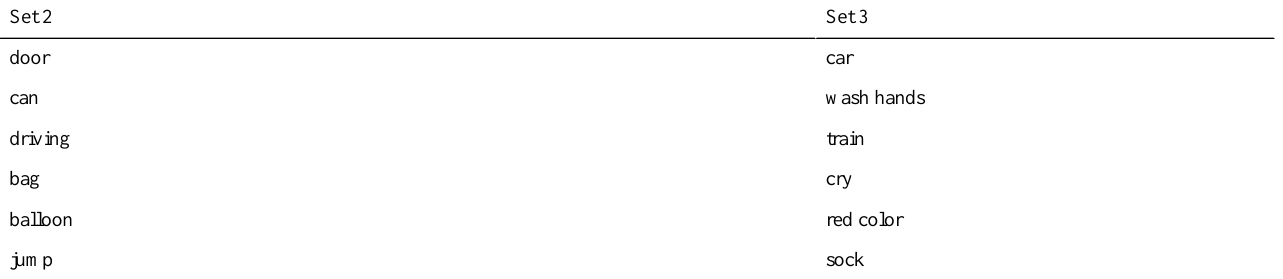
Table 1. Some of the test words.